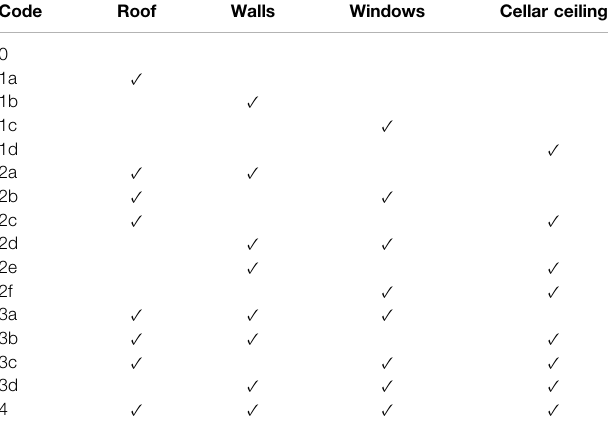
TABLE 4 | Combination of building envelope-based retro fi t measures implemented on the case study with the corresponding unique identifying codes used in subsequent fi gures (adapted from Sigrist et al. (2020))